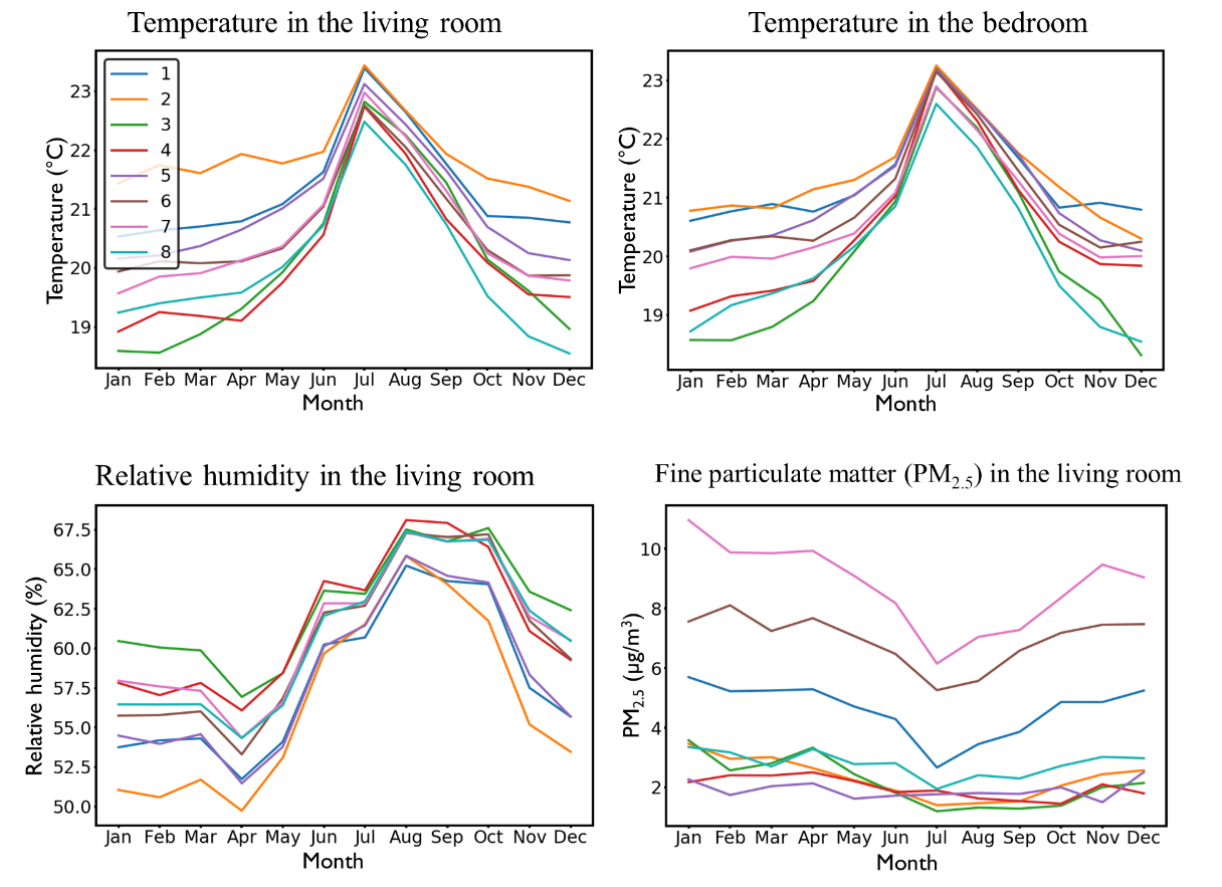
Figure 3. Smartline sensor data monthly means for the archetypes across 1 year. PM 2.5 : atmospheric particulate matter that have a diameter of less than 2.5